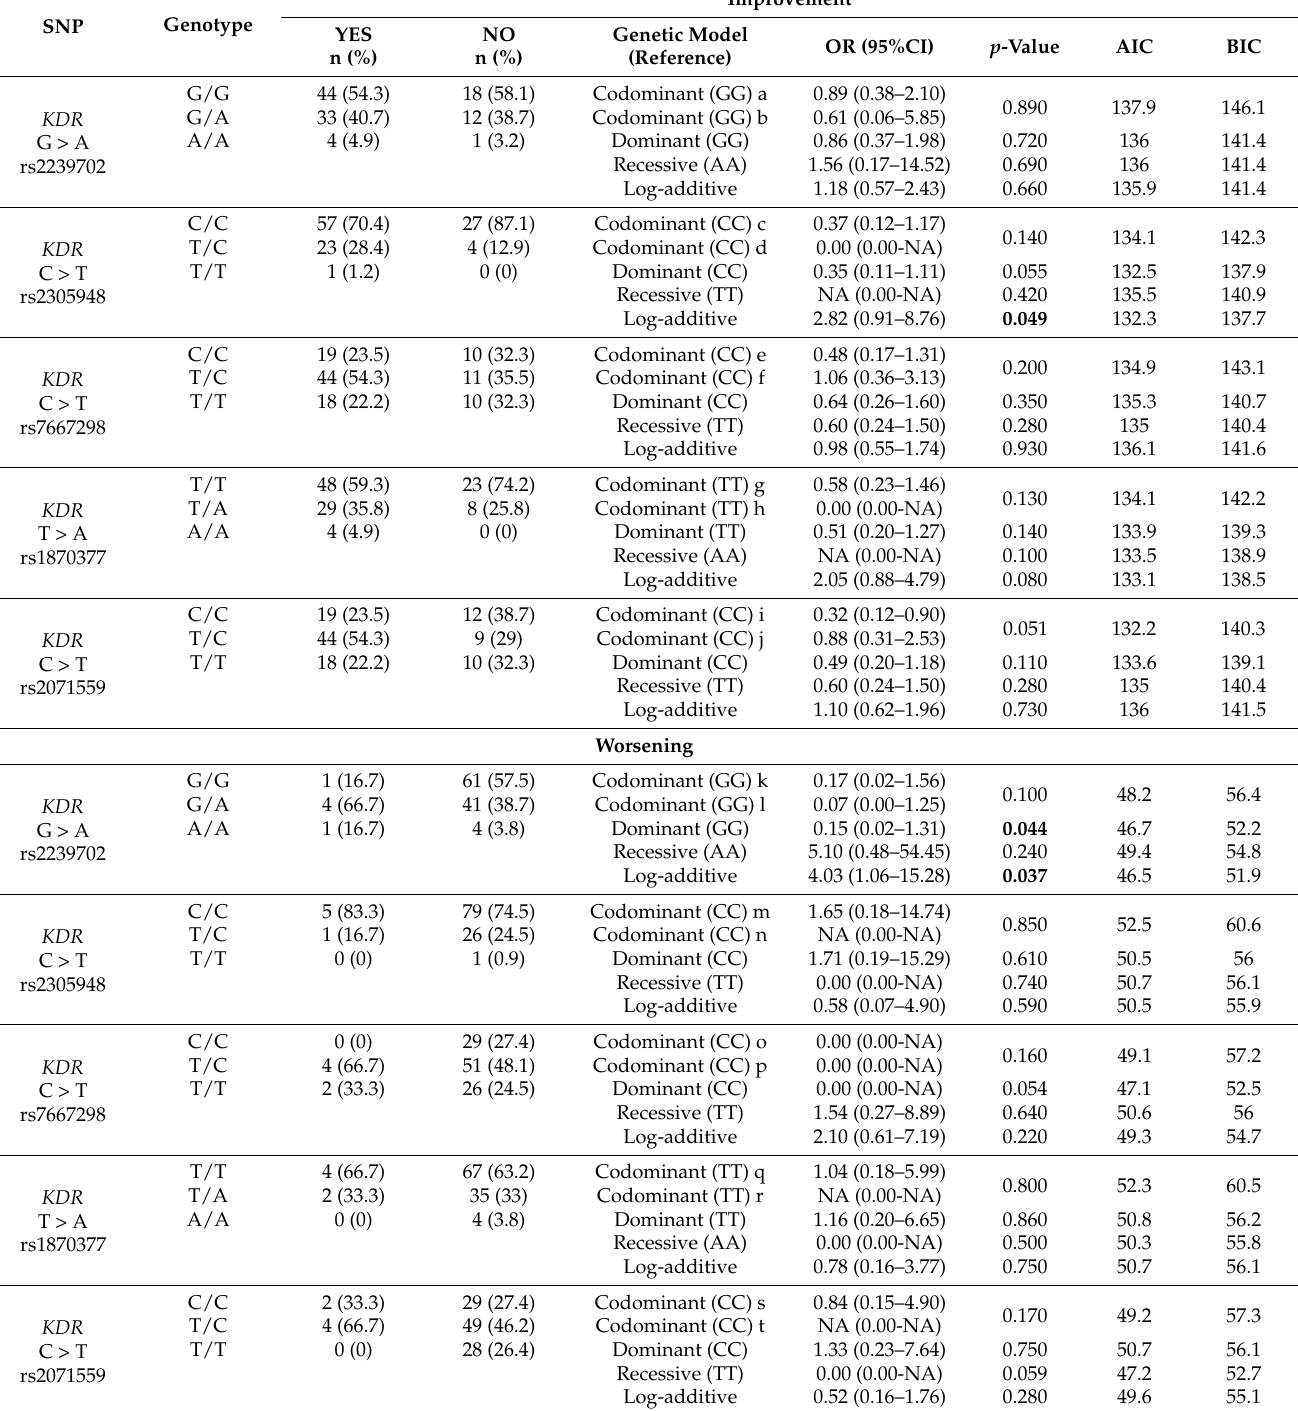
Table 4. Association study of KDR genotypes with BCVA improvement/worsening at 12